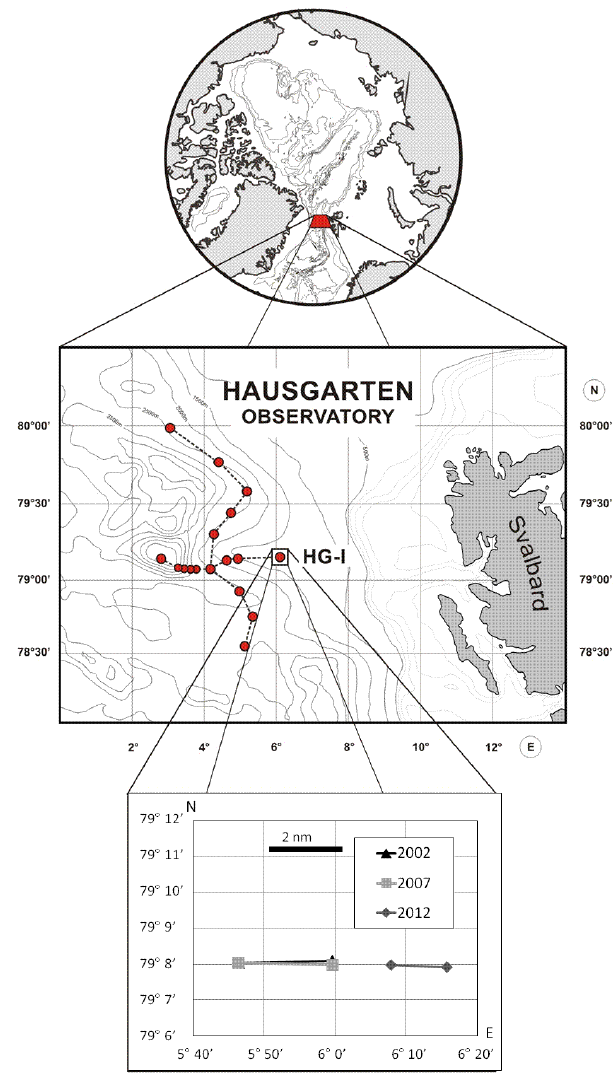
Fig. 1. Location of OFOS transects at HAUSGARTEN I sampled in 2002, 2007, and